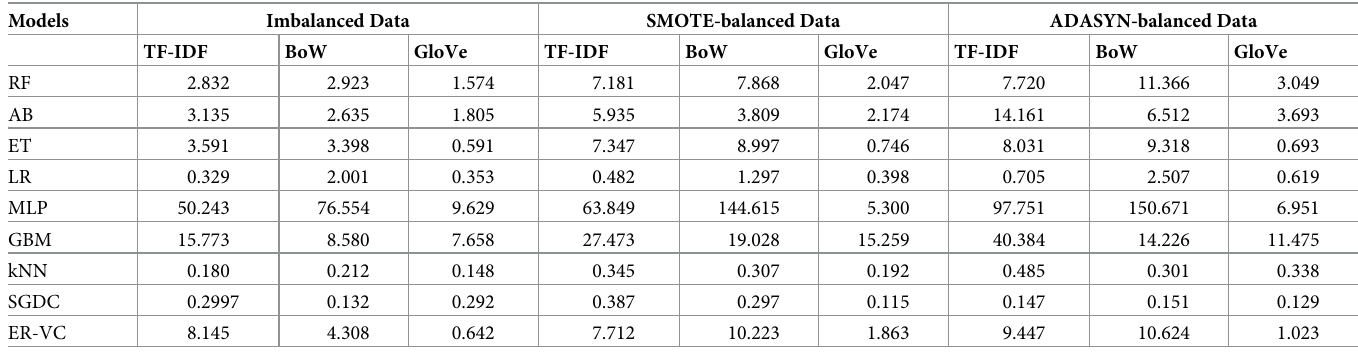
Table 12. Execution time (seconds) of machine learning models.